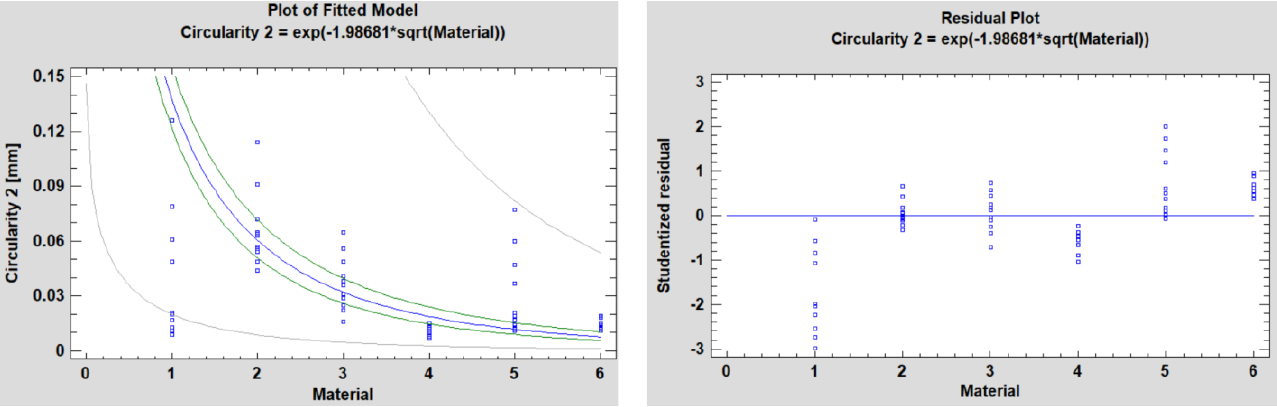
Figure 9. Plot of fitted model and residual plot for circularity 2 using the Logarithmic-Y square root-X model of the simple regression.